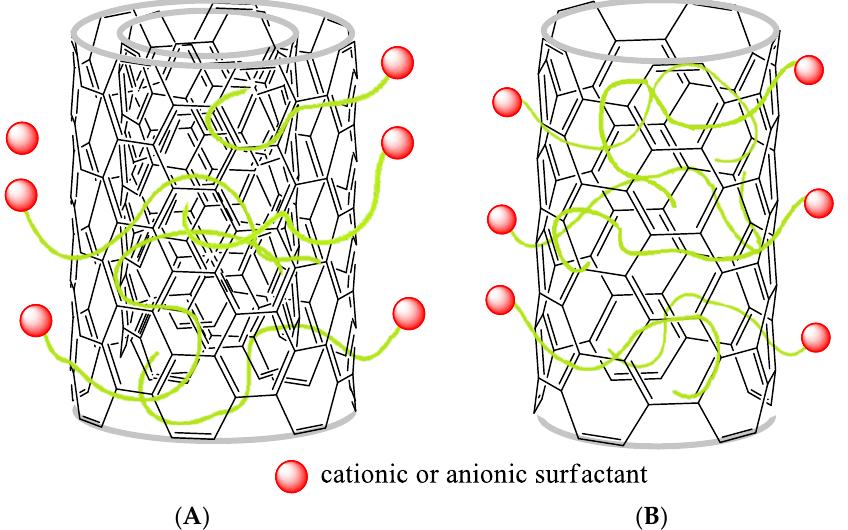
Figure 2. Schematic picture of the adsorption of anionic and cationic surfactants on the MWCNT ( A ) and SWCNT ( B ) surface.